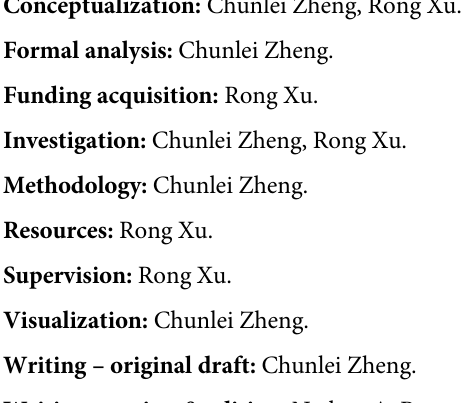
S1 Table. Patient characteristics of original data from TCGA. S2 Table. Patient characteristics of validation data. S3 Table. The associations of epigenetic age acceleration with clinical variables in valida- tion data. S4 Table. Overall survival of gliomas patients in validation dataset using multivariate anal- ysis. S5 Table. The association of age acceleration with patient overall survival in stratified anal-